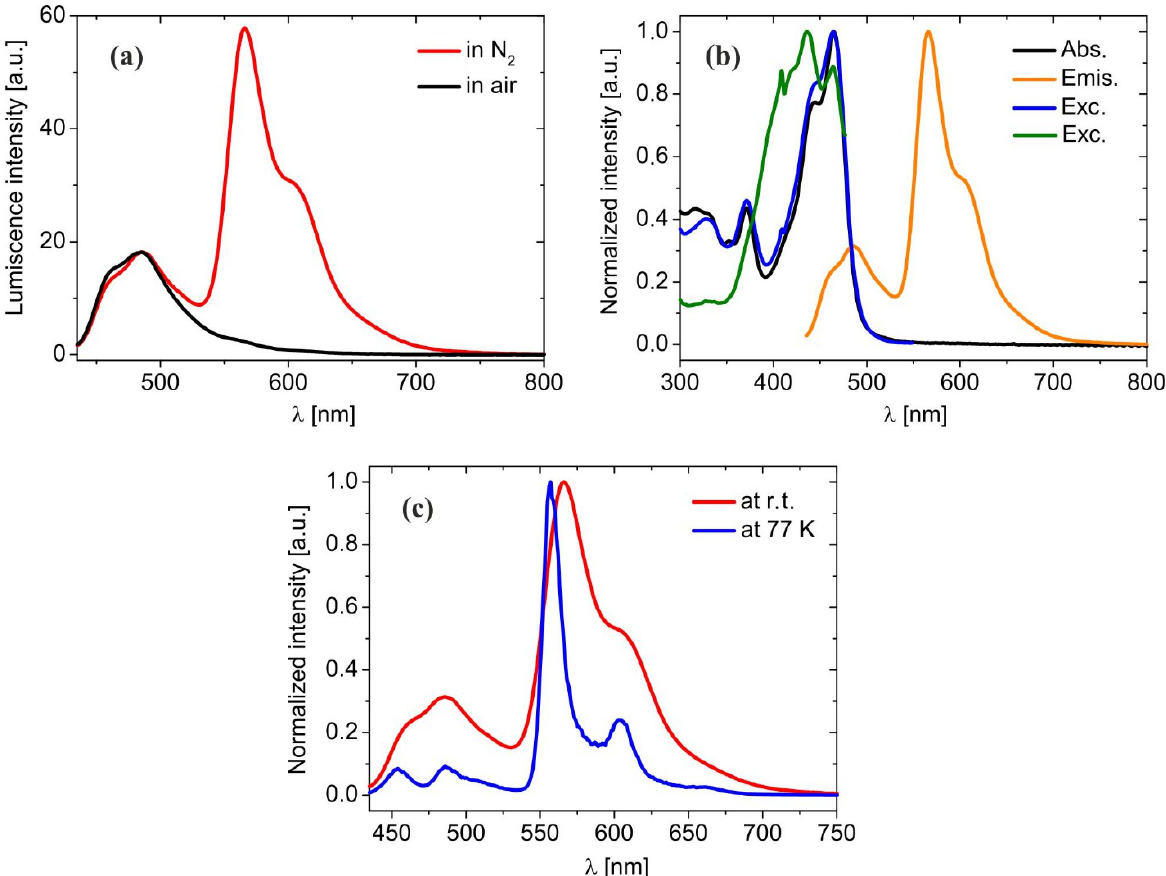
Figure 11. Emission spectra of aerated and deoxygenated samples of complex 1 ( a ) in DCM solution λ exc = 420 nm; ( b ) comparison of the absorption, emission, and excitation spectra at λ = 565 nm (blue) and λ = 477 nm (green) in DCM at r. t.; ( c ) emission spectra at r. t. in DCM and at T = 77 K (λ exc = 400 nm) in frozen